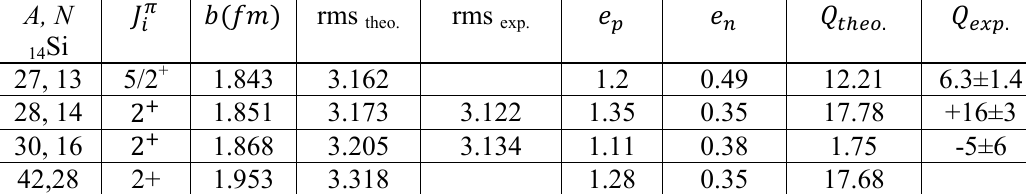
Table 2: Quadrupole moments in units of (cid:2187) (cid:2188)(cid:2195) (cid:2779) calculated with harmonic oscillator (HO) potential for Silicon (Si) isotopes (Z = 14). Effective proton and neutron charges are deduced from the core polarization calculation. Experimental quadrupole moments are taken from Ref.